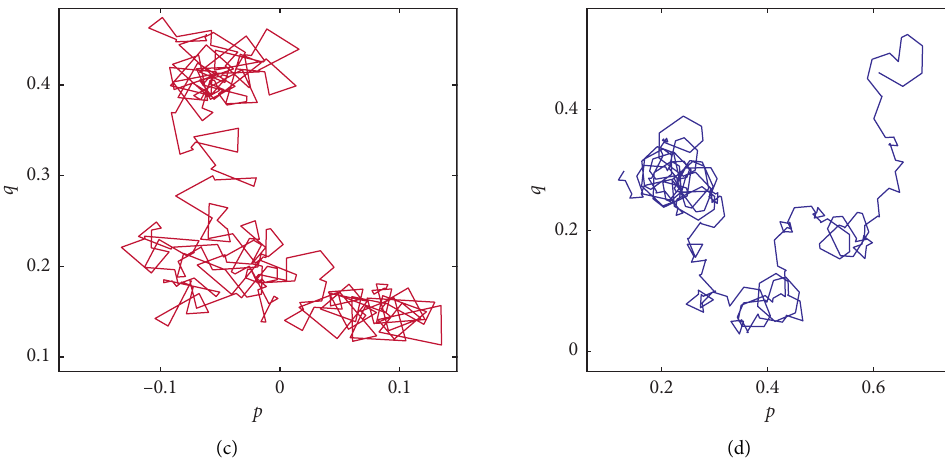
Figure 4: (a) and (b) represent ( p, q ) -plots for system (13) with f � 0 . 001 and 0.012, respectively. In order to calculate p and q , we choose 0 y -component of system (13) with the initial condition ( 0 , − 0 . 0032 ) . Same plots are represented in (c) and (d) with respect to the different � 0 . 012. In both the cases, the values of parameters are considered same as initial conditions ( 0 , − 0 . 00161 ) and ( 0 , − 0 . 00261 ) for fixed f 0 chosen in Figure 2. In each calculation, the value of (c) is considered as ( 2 π /3 ) .